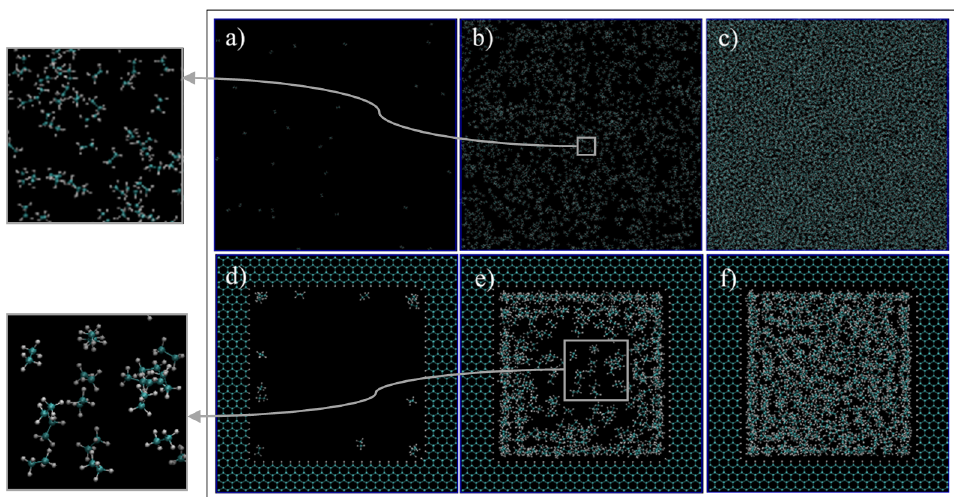
Figure 4. Ethane molecules simulation in bulk ( a – c ) and in the nano-pore ( d – f ) at C1 ( a , d ), C2 ( b , e ), and C3 ( c , f ). C1, C2, and C3 refer to temperature and pressure conditions of 68 ◦ F and 14.7 psia, 68 ◦ F and 546.21 psia, and 68 ◦ F, 4000 psia, respectively. Cyan and white spheres are carbon and hydrogen atoms,